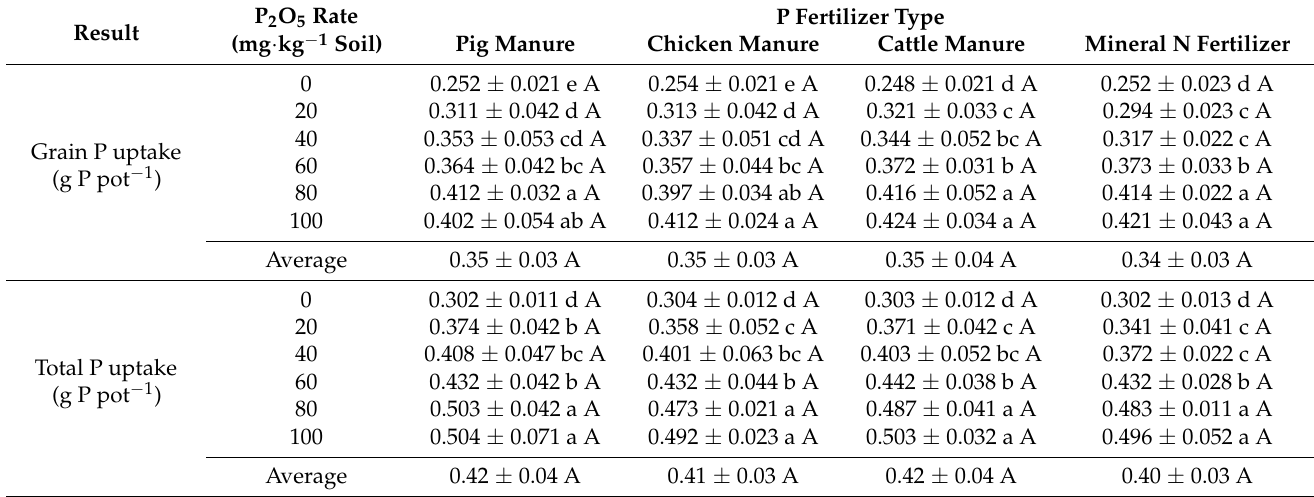
Table 6. Effects of different P fertilizers on P uptake in different organs of